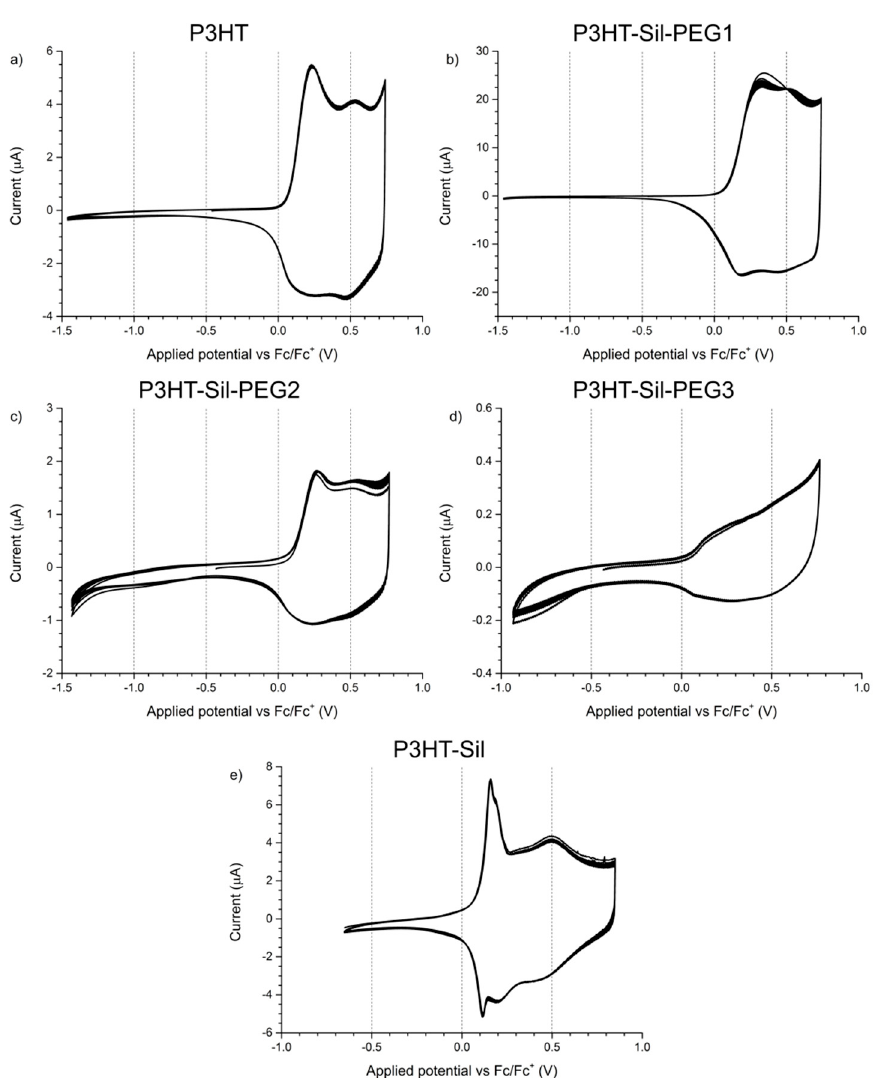
Figure 4. Electrochemical response of thin solid films of ( a ) regioregular P3HT; ( b ) P3HT-Sil-PEG1;